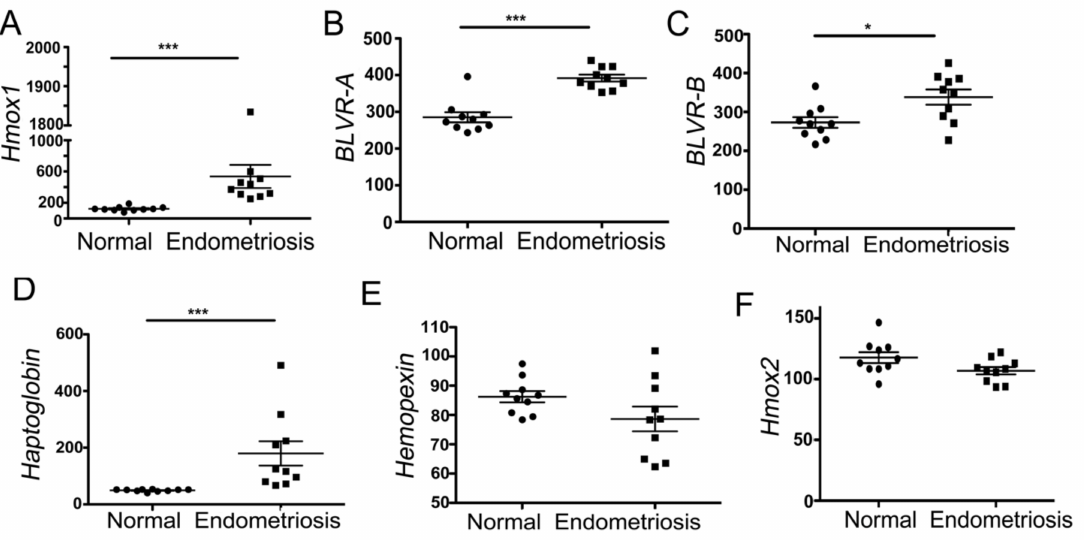
Figure 1. HO-1 and heme-associated protein levels in ovarian endometriosis and normal en- dometrium ( A – F ). Here, mRNA expression Geo Profiles from 10 ovarian endometriosis and 10 matched normal endometrium biopsies from the same patient were used [24]. Mean values ± SD are shown. * p < 0.05. *** p <